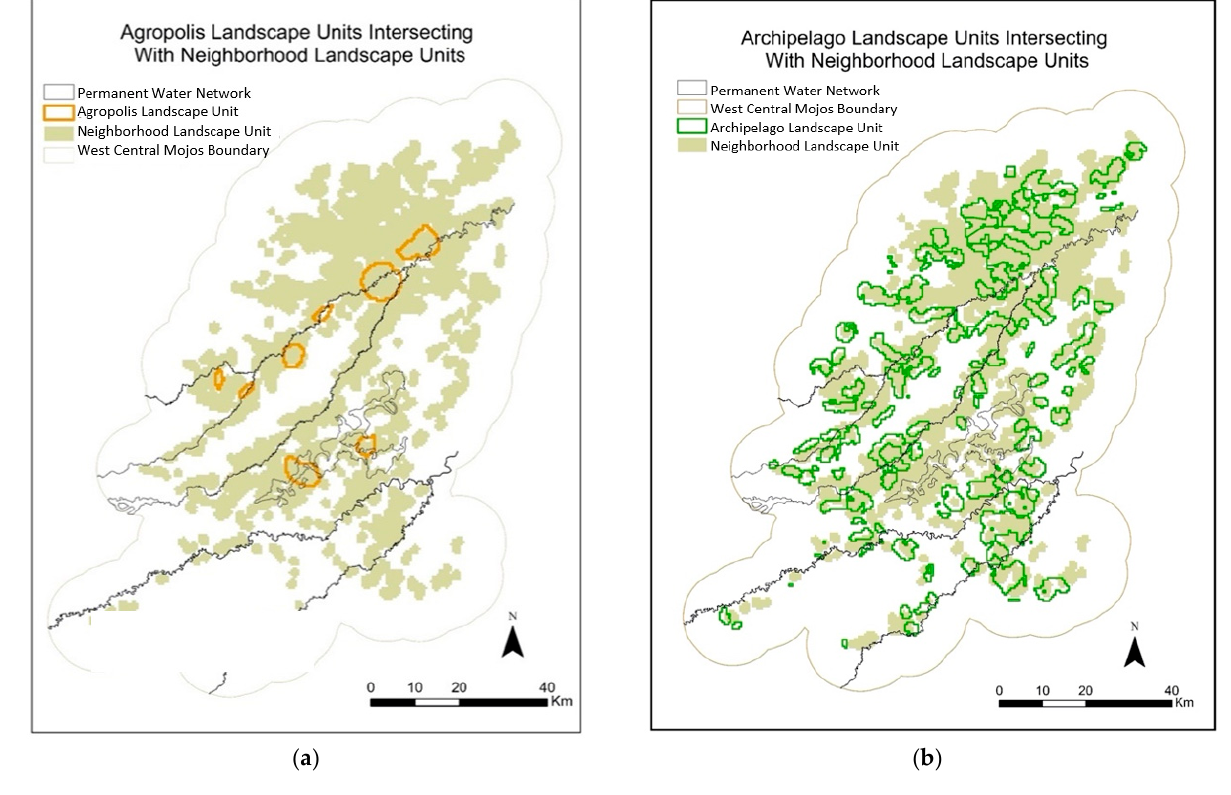
Figure 6. ( a ) Agropolises intersected with neighborhoods, showing how raised fields surround agropolis landscapes. ( b ) Archipelagos intersected with neighborhoods, showing how archipelagos and raised fields are more integrated in some areas. Table 3. All forest islands in the project were sorted into three groups. The smallest forest islands were used to identify archipelago landscape units. The largest forest islands were used to identify agropolis landscape units. All forests that are too large for the archipelago units and too small for the agropolis units were part of a third undefined group. These mid-size forest islands were used to identify buffer landscape units.